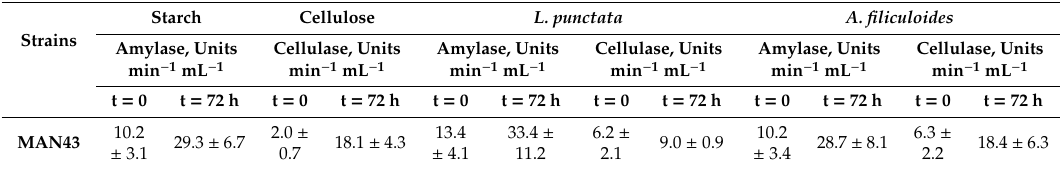
Table 3. Supernatant analysis for enzyme activity.